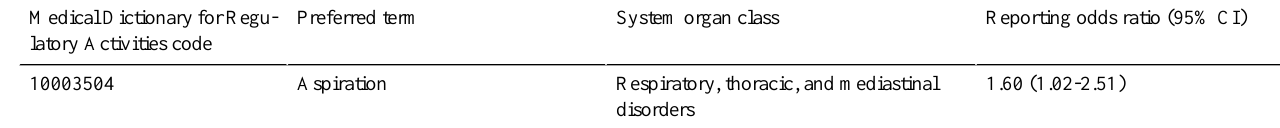
latory Activities